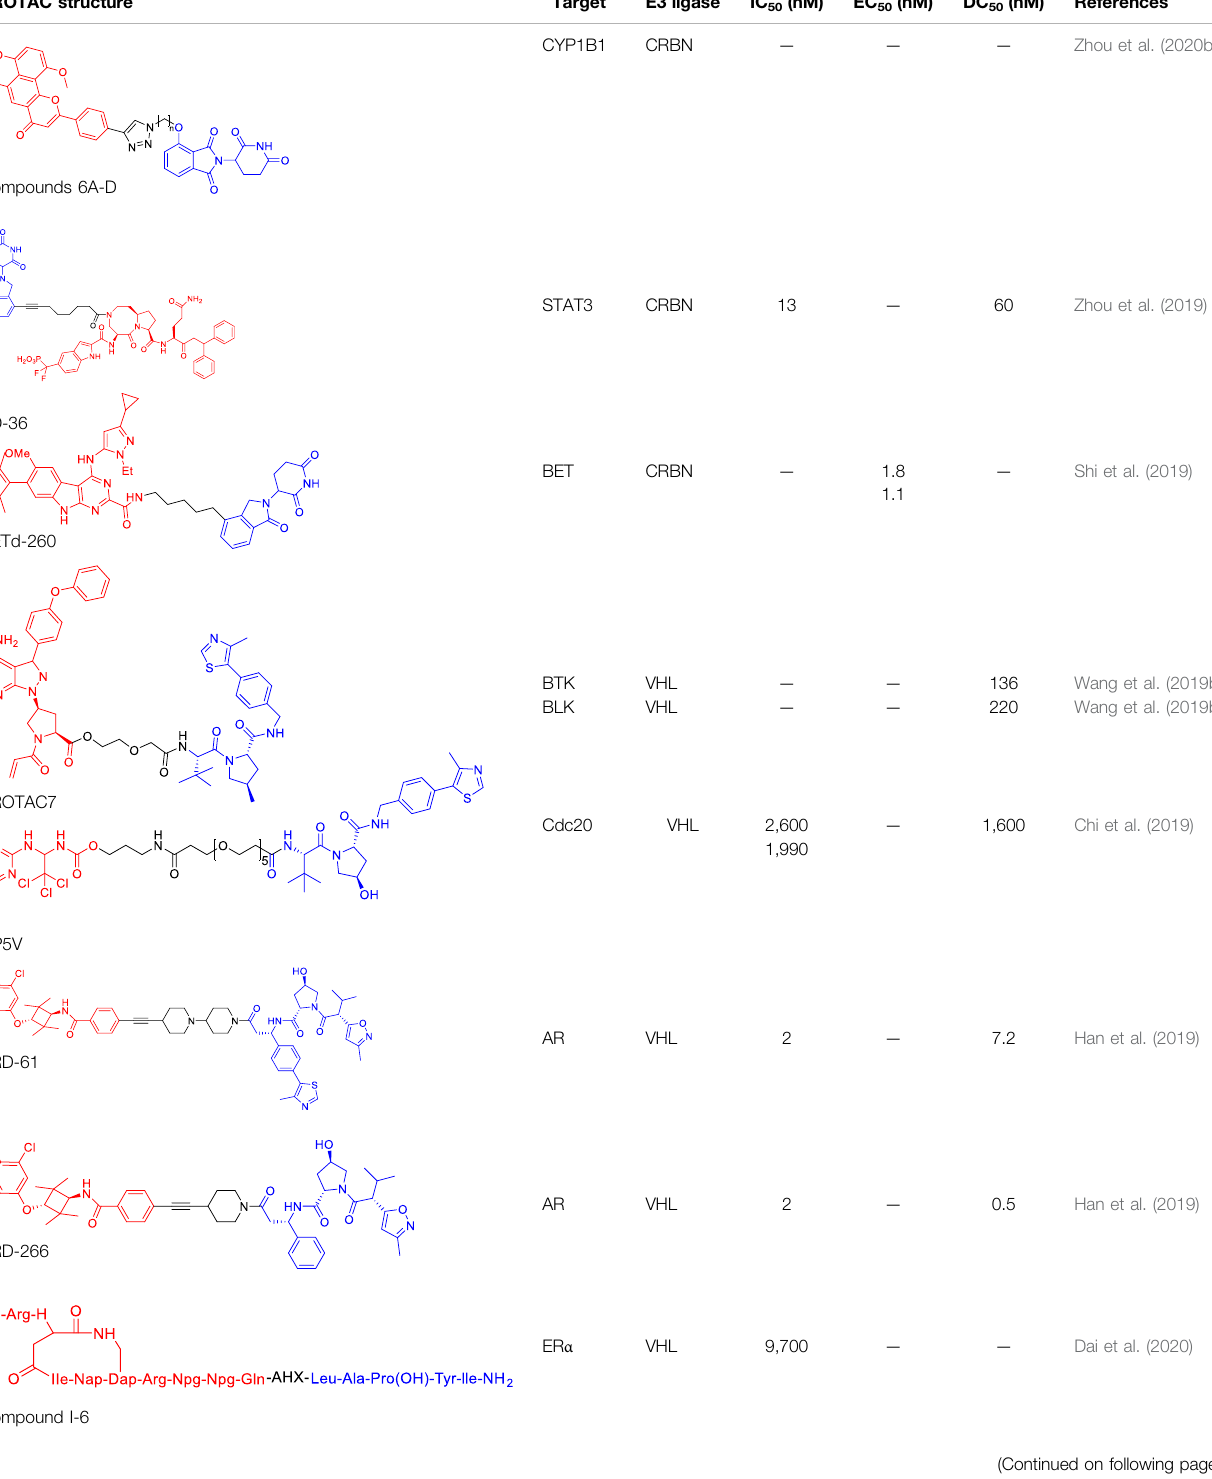
TABLE 1 | ( Continued ) Representative small-molecule PROTACs under